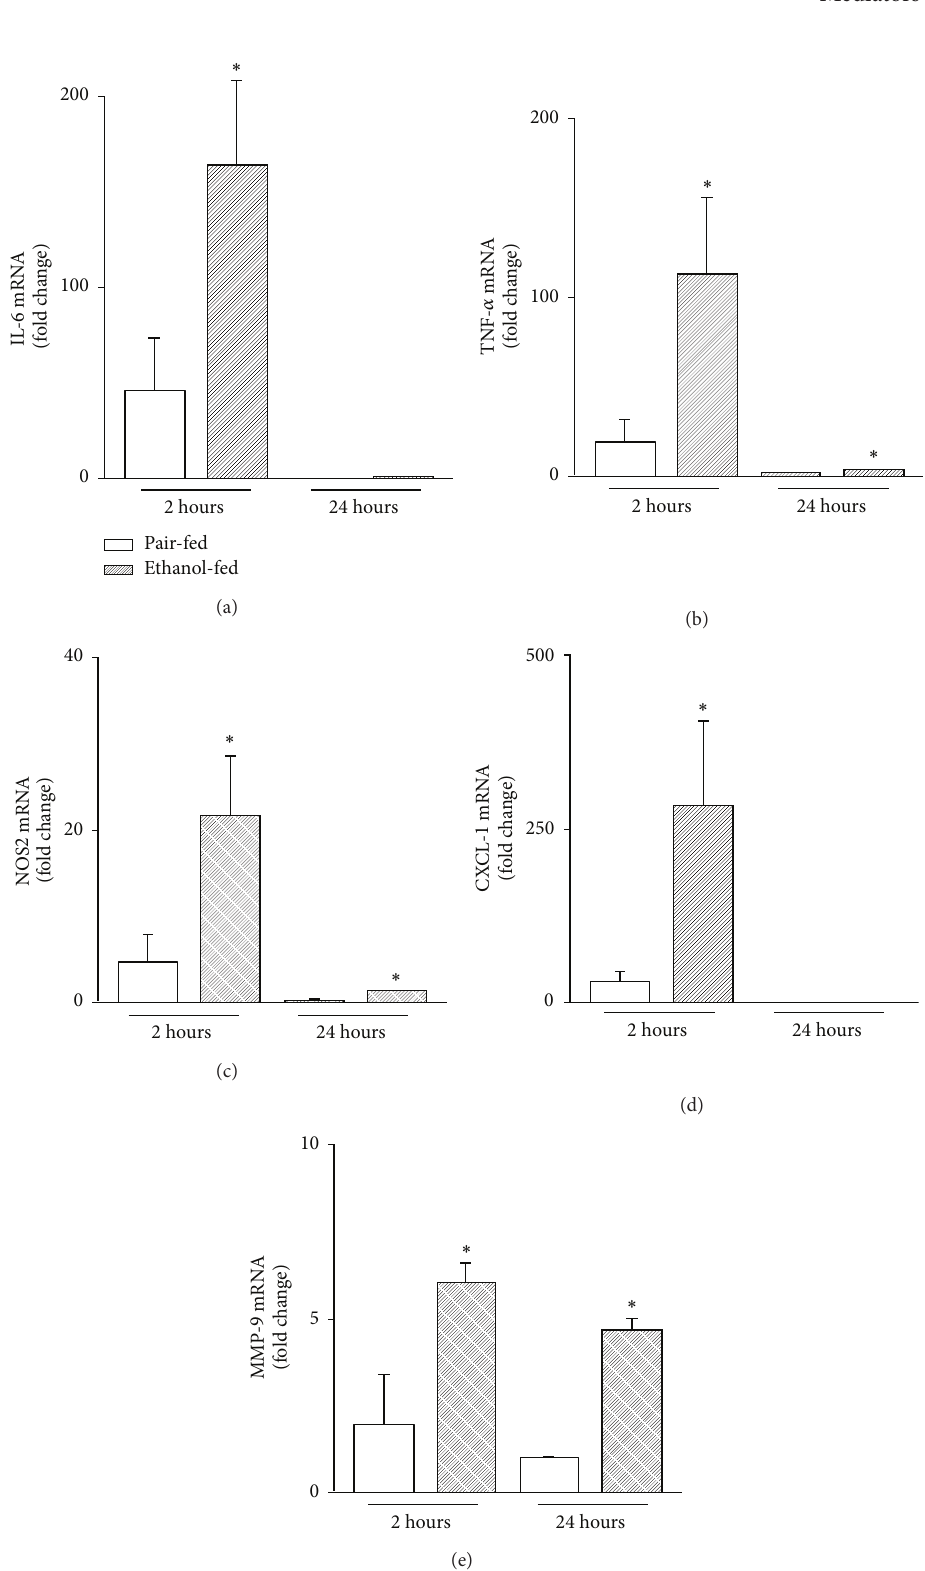
Figure 7: NF- 𝜅 B target gene expression in isolated Kupffer cells in response to LPS after ethanol feeding F4/80 + macrophages were isolated from livers of ethanol-, pair-fed mice, respectively, and stimulated with LPS (10 𝜇 g/mL, Figure 7) for 2h and 24h. Supernatants were measured for mRNA levels of IL-6 (a), TNF- 𝛼 (b), NOS2 (c), CXCL-1 (d), and MMP-9 (e) by RT-PCR. Data (mean ± SEM) are expressed as fold change compared with corresponding medium controls (unstimulated) and are representative of five to eight separate experiments. ∗ 𝑃 < 0.05 versus pair-fed